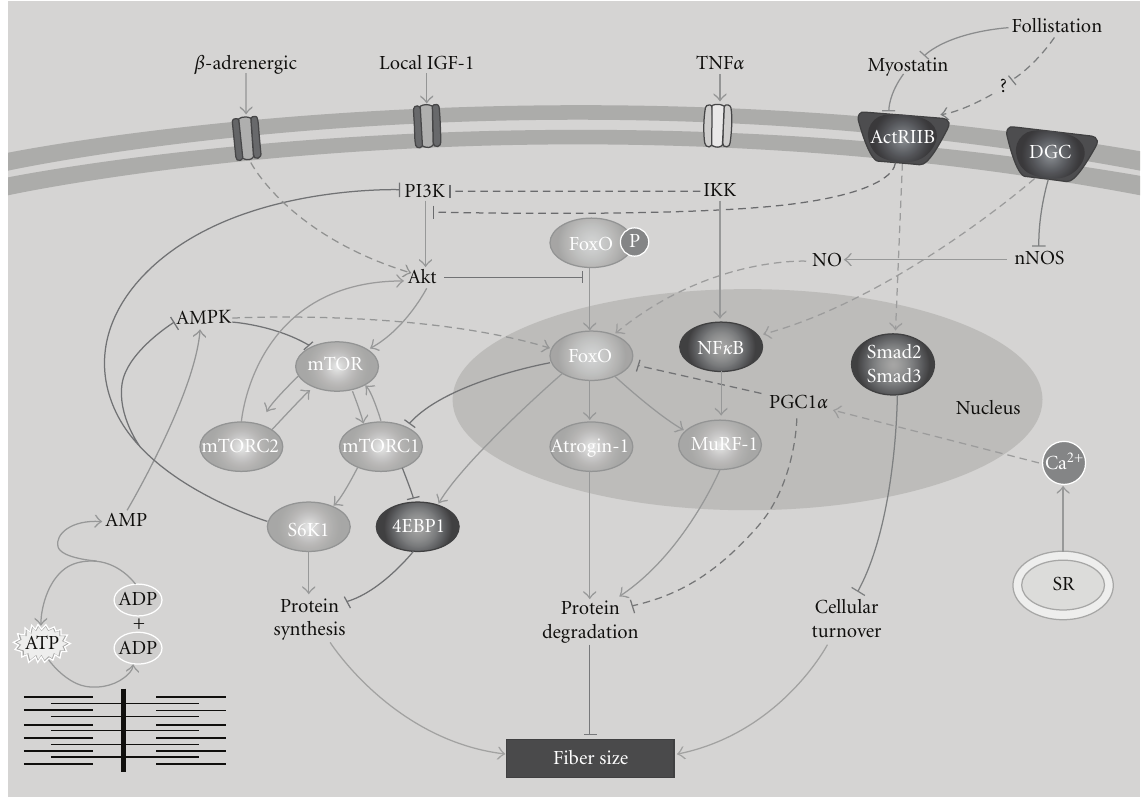
Figure 5: Net of signaling systems participating in regulation of fiber size of skeletal muscle under disuse atrophy. Pathways whose molecular function in the cell is not known are dashed